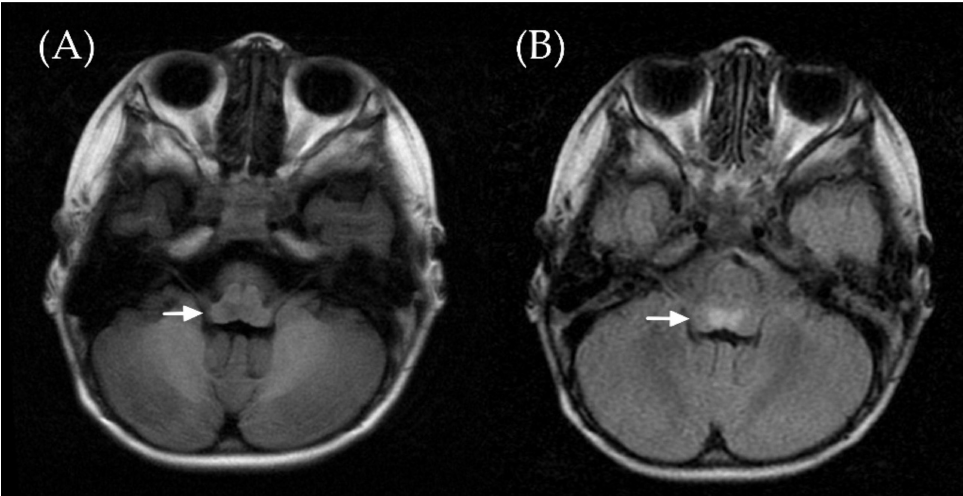
Figure 2. Brain magnetic resonance imaging showed symmetric lesions involving the dorsal pons and medulla oblongata, revealing brainstem encephalitis. These lesions (arrow) were hypointense in the T1-weighted FLAIR sequence panel ( A ) and hyperintense in the T2-weighted FLAIR images panel ( B